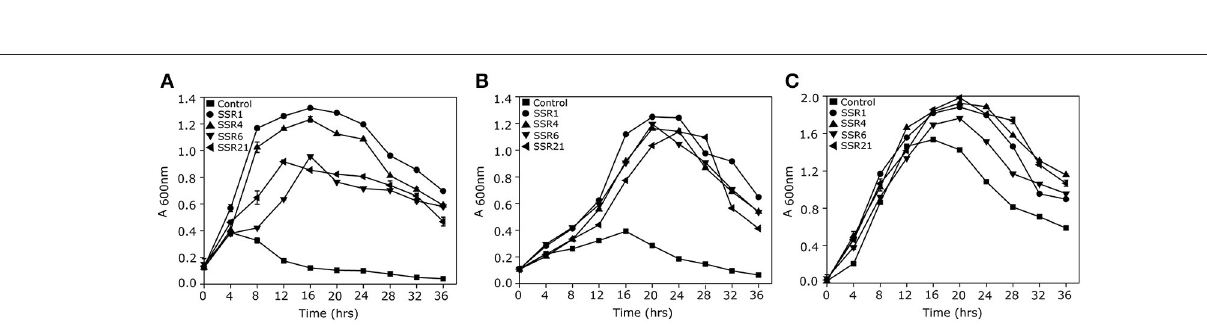
FIGURE 2 | Characterization of salt stress tolerant clones for osmotolerance property. Growth of E. coli (DH10B) metagenomic clones SSR1 (•), SSR4 ( N ), SSR6 ( H ),SSR21( ◭ ), and E. coli (DH10B) host strain carrying empty plasmid vector ( (cid:4) ) in (A) LB broth supplemented with 4.0% NaCl (w/v), (B) LB broth supplemented with 5.5% KCl and (C) LB broth.